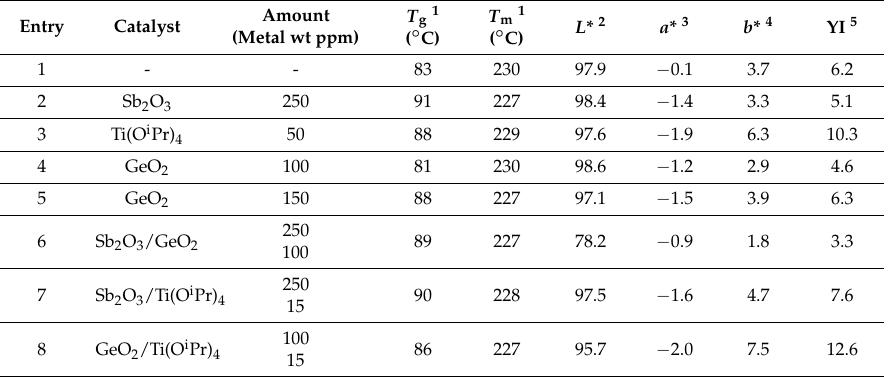
Table 2. Thermal properties and colorimetric analyses of PEIT formed using the different